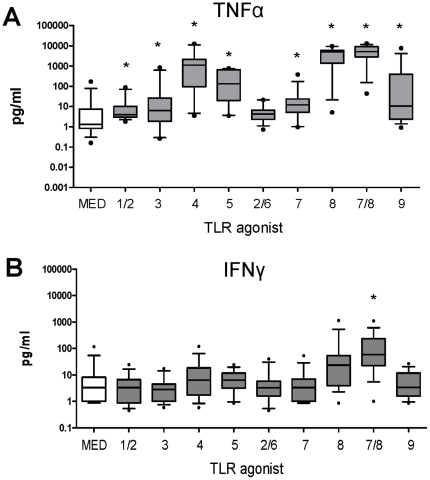
TLR-mediated cytokine production in cord blood.100 µl of whole cord blood was cultured overnight with each of the
TLR agonists and supernatants recovered for measurement of (A) TNFα
and (B) IFNγ as described in Materials
and Methods (pg/mL) and presented as box and whisker plots
illustrating 10 and 90 percentile error bars,
n = 12–15. Comparisons
between cytokine levels in the stimulated samples and the unstimulated
samples were analysed using a paired Sign test at 5% significance
(* represent significant differences).